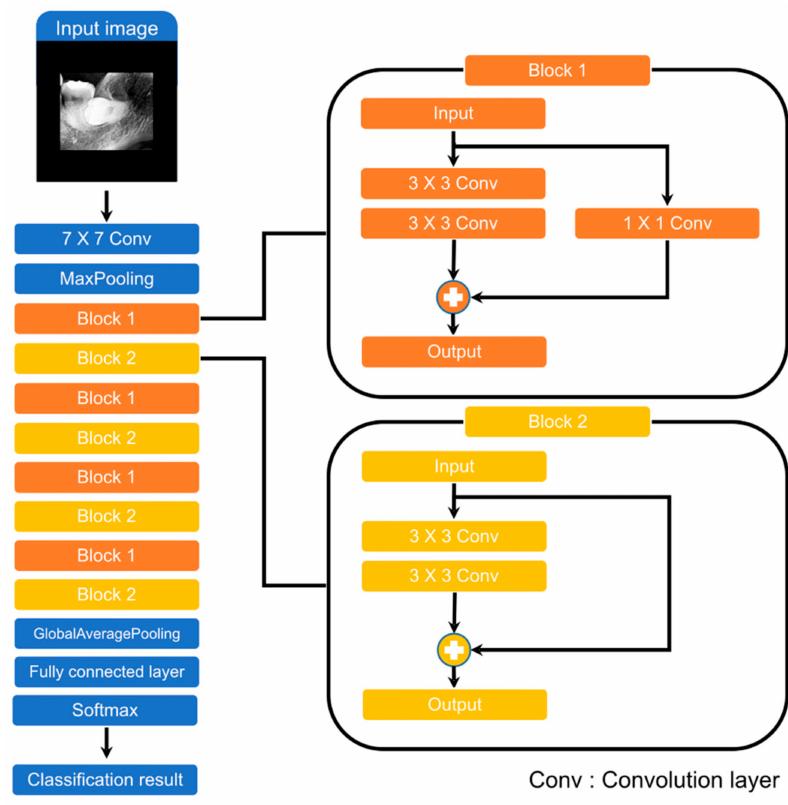
Figure 3. ResNet-18